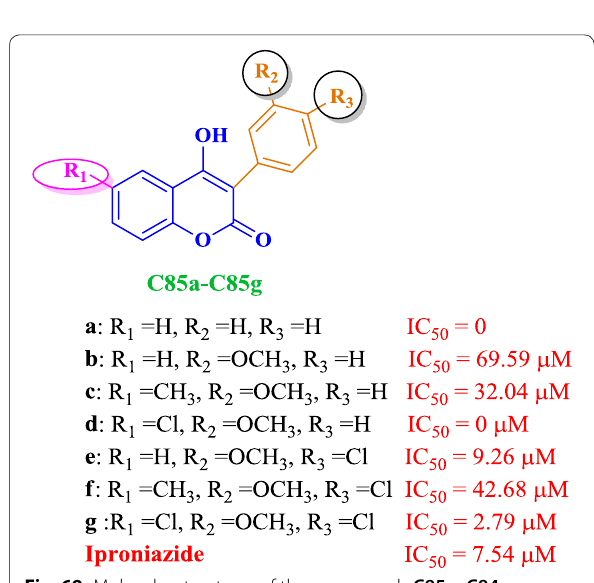
Fig. 69 Molecular structures of the compounds C85a –